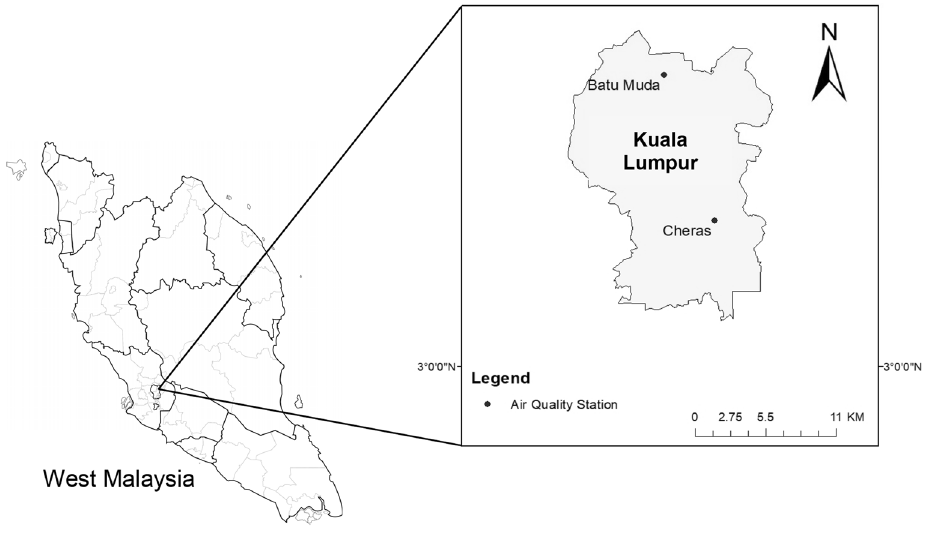
Figure 1. Air quality monitoring stations 40